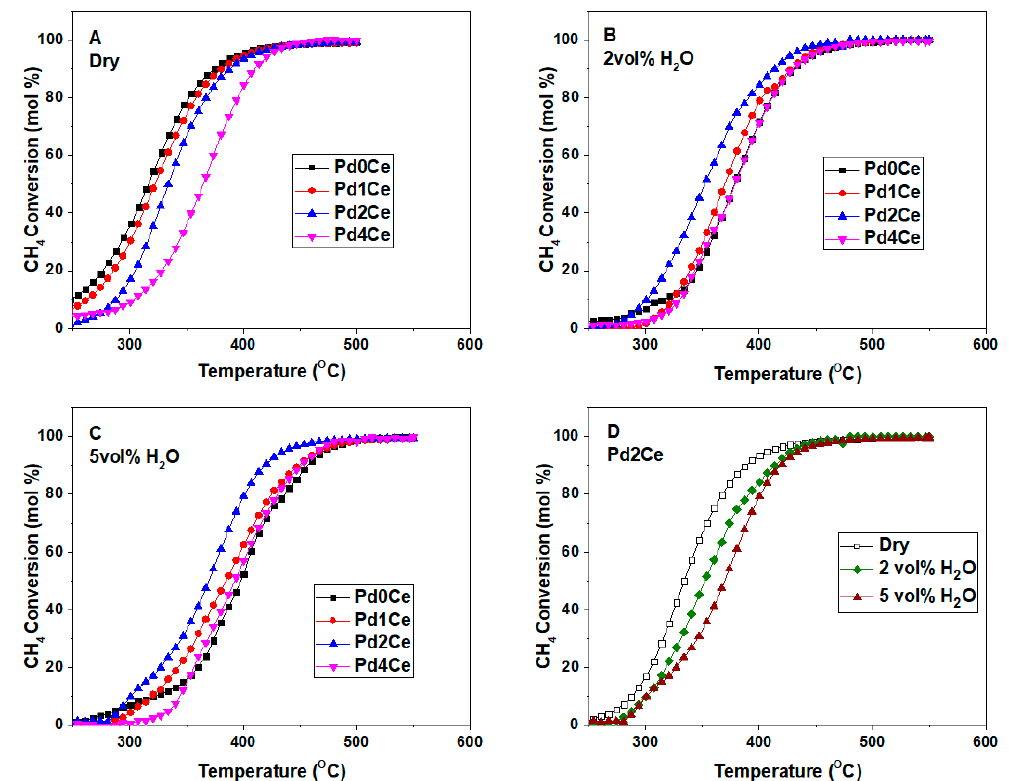
Figure 4. Temperature-programmed CH 4 oxidation profile showing the initial activity of the catalysts as a function of temperature. Reaction conditions: GHSV of 36,000 h − 1 , Feed gas composition: 0.07 vol.% CH 4 , 8.5 vol.% O 2 , 0.06 vol.% CO, 8 vol.% CO 2 and 0, 2 or 5 vol.% H 2 O in N 2 and He. ( A ) Dry feed 0 vol.% H 2 O; ( B ) Wet feed 2 vol.% H 2 O; ( C ) Wet feed 5 vol.% H 2 O; ( D ) Initial activity of Pd2Ce catalyst.